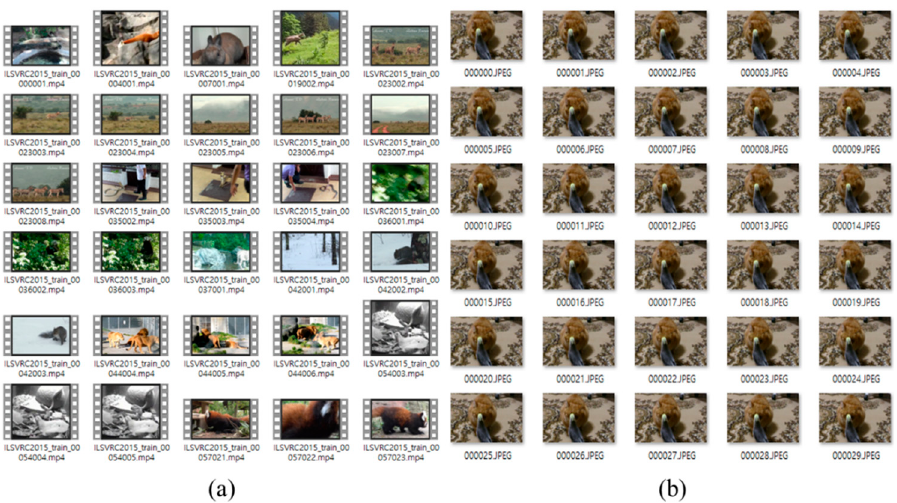
Figure 8. Information of ILSVRC 2017 VID Datasets: ( a ) Video snippets, ( b ) Extracted image frame of snippets.